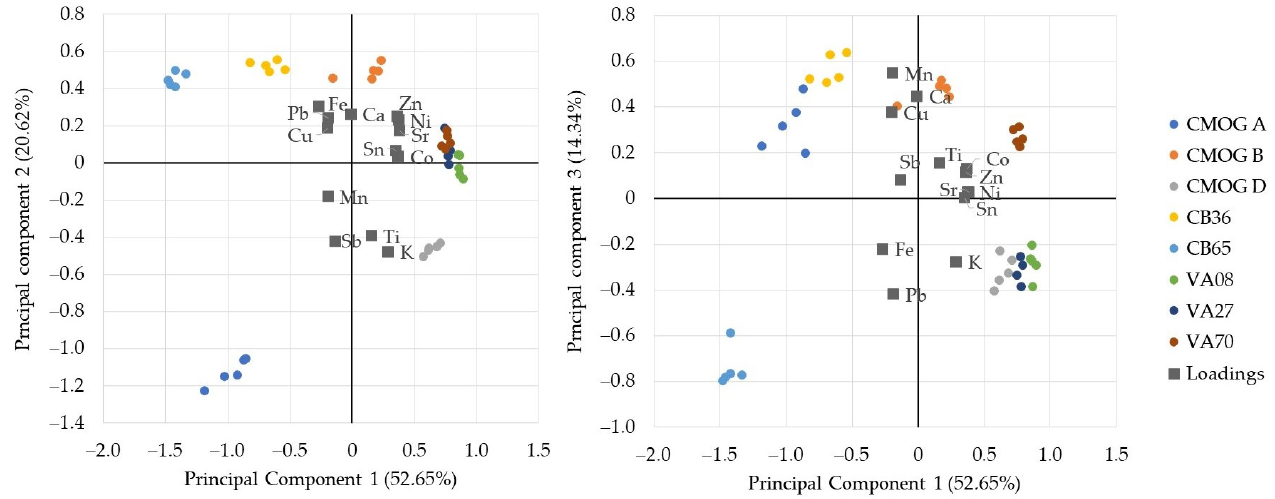
Figure 7. PCA of the dataset. Biplots for PC1 vs. PC2 ( left ) and PC1 vs. PC3 ( right ). Squares: loading. Circles: scores. Five points of each sample are from each unit of equipment (four) plus the nominal concentration (one). The numbers in parenthesis represent the variance